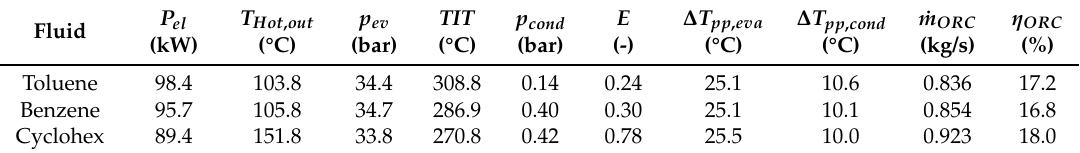
Table 6. Most promising pure fluids using ICE nameplate